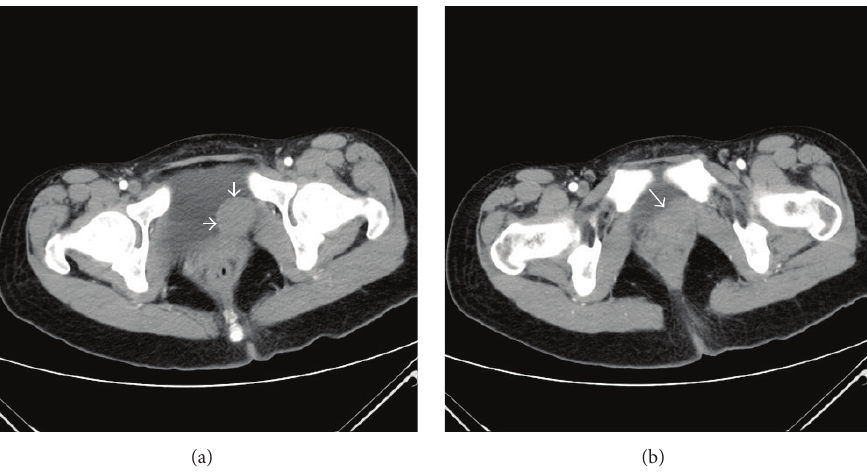
Figure 1: Contrast-enhanced computed tomography (CT). (a) shows a diameter of about 3cm soft, mild enhancement mass at the left posterior wall of the bladder, protruding into the bladder locally. (b) shows the mass that was adjacent to bladder neck and vagina.